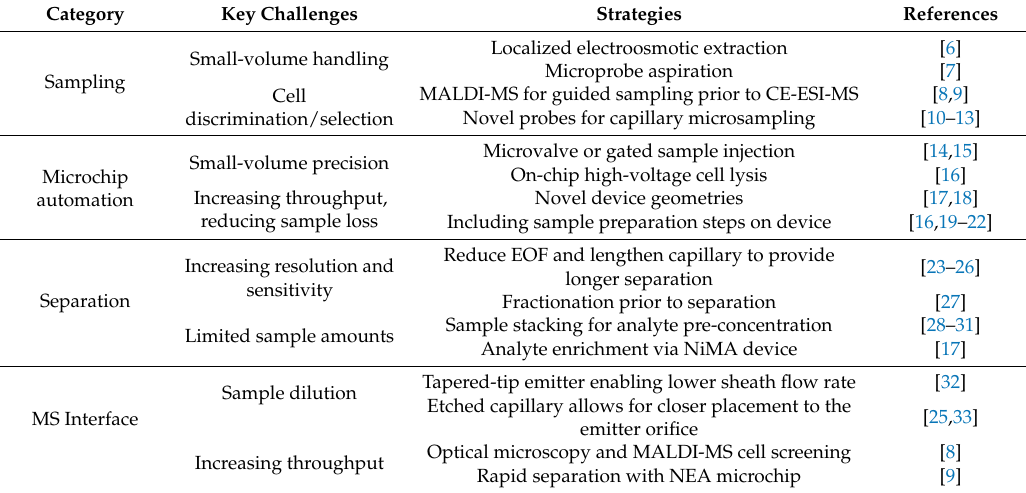
Table 1. Summary of some of the key challenges of single-cell capillary electrophoresis (CE)-mass spectrometry (MS) analysis, organized by section, as well as some notable strategies to address each challenge, accompanied by selected references. This table is intended to provide a general summary and not a comprehensive account of all developments to address each